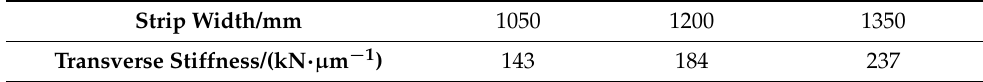
Table 10. Transverse stiffness with different strip